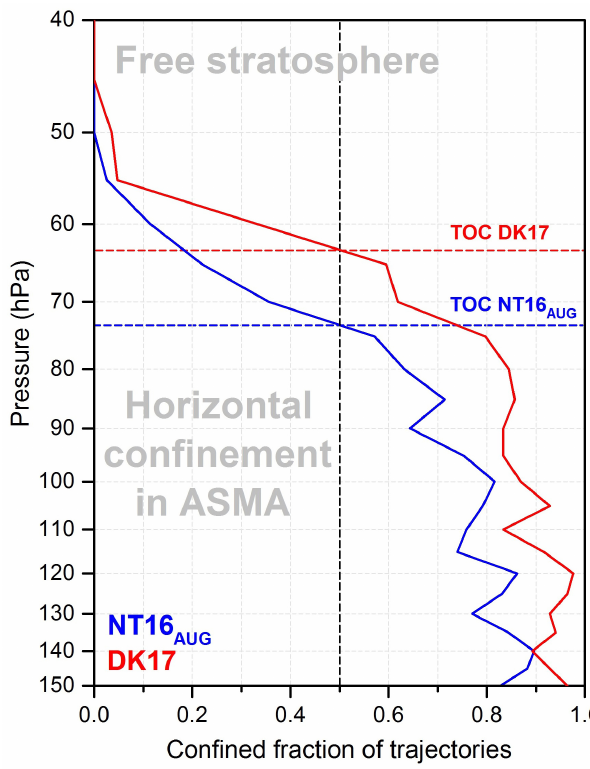
Figure 5. Confined fraction of trajectories (see Sect. 5.2) as a func- tion of pressure for the NT16 AUG (blue) and DK17 (red) campaign periods. Dashed lines mark the TOC level for NT16 (blue) and DK17 (red) and the 50% confined fraction threshold